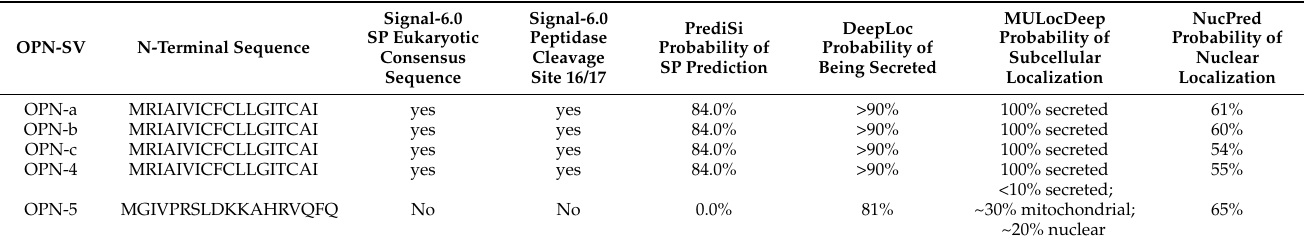
Table 1. Predictions for SP and subcellular localization for OPN-SV protein